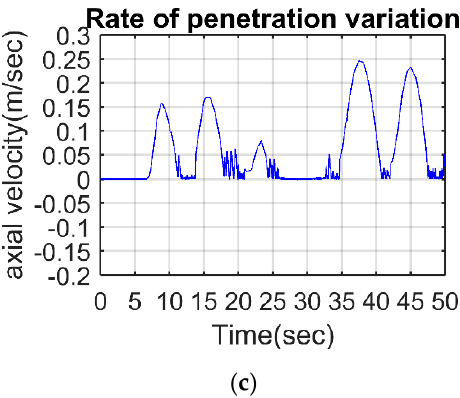
Figure 8. Results of system responses for first scenario: ( a ) angular velocities, ( b ) Tob, ( c ) ROP.